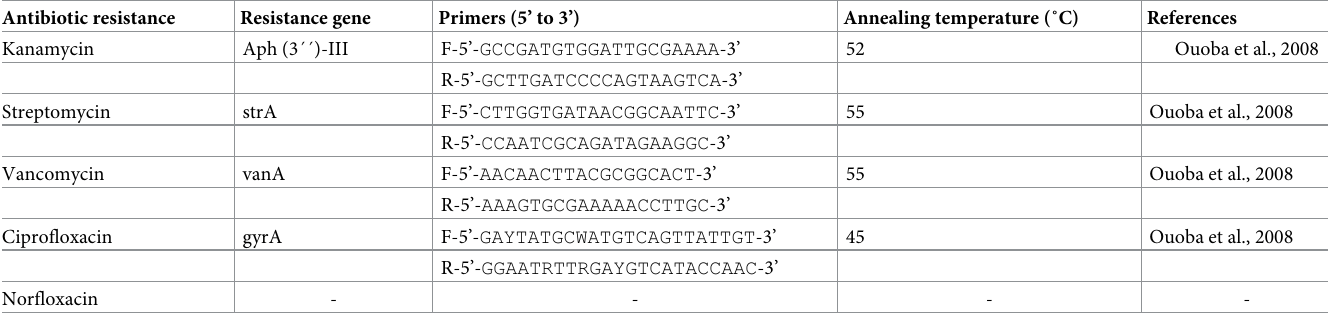
Table 4. Primers used for detection of antibiotic resistance genes of P . pentosaceus OBK05. Antibiotic